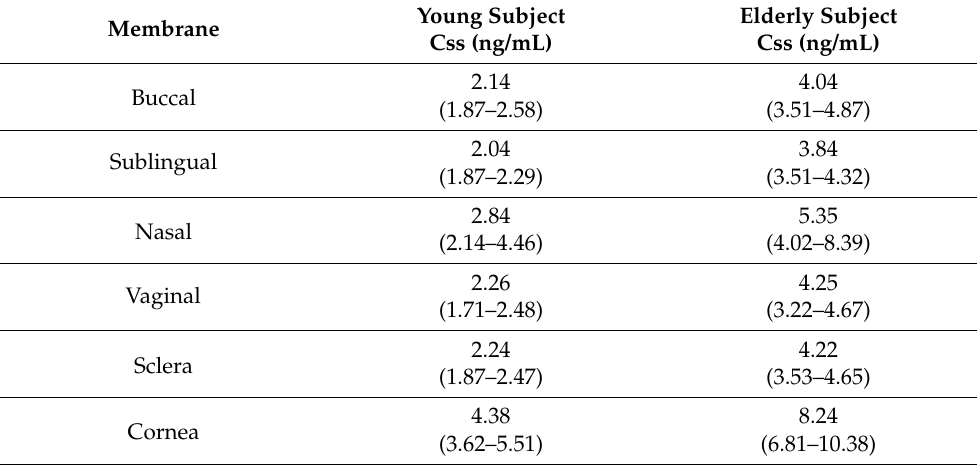
Table 13. Predicted plasma levels of PF at the steady-state (Css) for the young and elderly populations, obtained from the selected formulation applied on 1 cm 2 of porcine mucous membrane (buccal, sublingual, nasal and vaginal) and ophthalmic tissues (sclera and cornea). Data are reported as median (min-max).